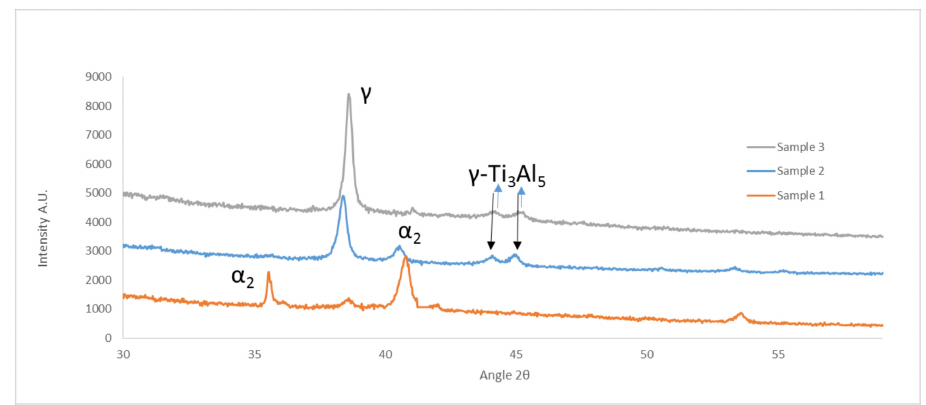
Figure 7. XRD patterns of sample 1 (26 at. % Al), sample 2 (48 at. % Al), and sample 3 (56 at. % Al) heat-treated at 1430 ◦